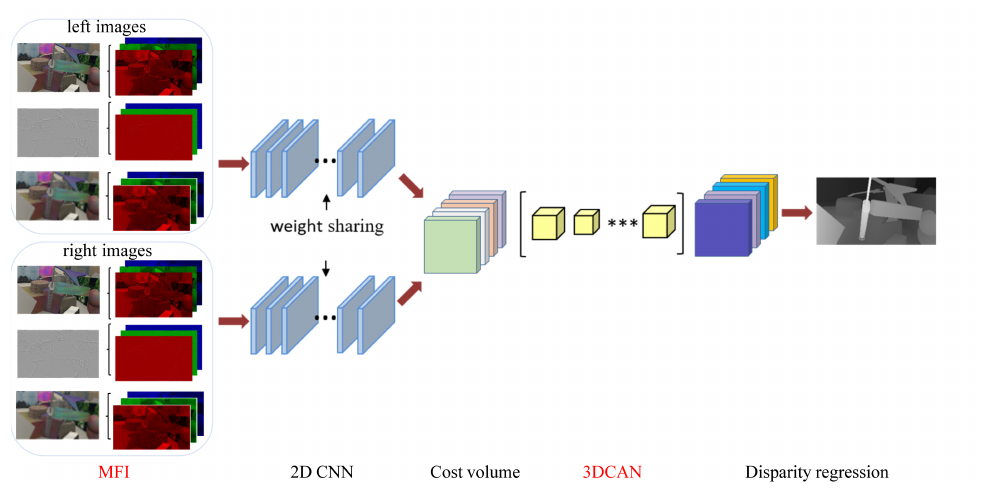
Figure 2. Architecture of our stereo matching network. It consists of five main steps, obtaining multiple frequency inputs, 2D CNN for feature extraction, cost volume, attention-based cost volume regularization and disparity